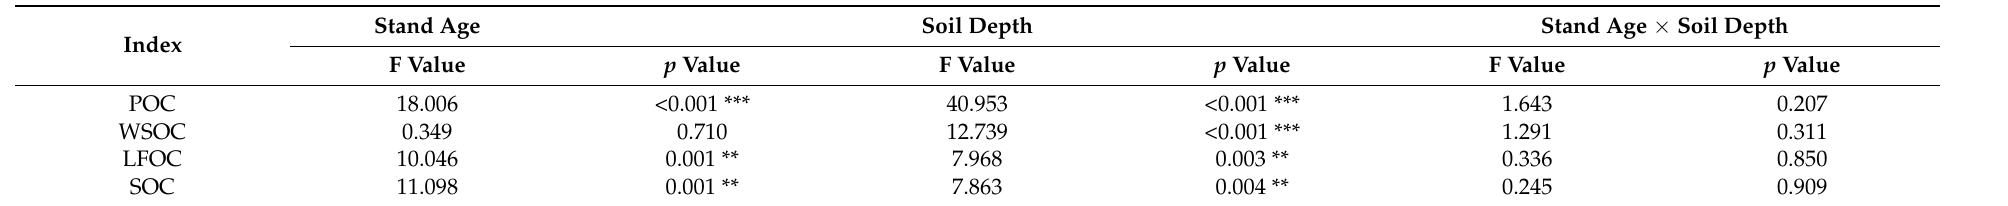
Table 3. Effects (F-ratio, p -values) of stand age, soil depth, and their interactions on the concentration of soil carbon fractions. SOC, soil organic carbon; POC, particulate organic carbon; WSOC, soil water-soluble organic carbon; LFOC, light fraction organic carbon. * represents statistical significance, in which ** p < 0.01, and *** p <